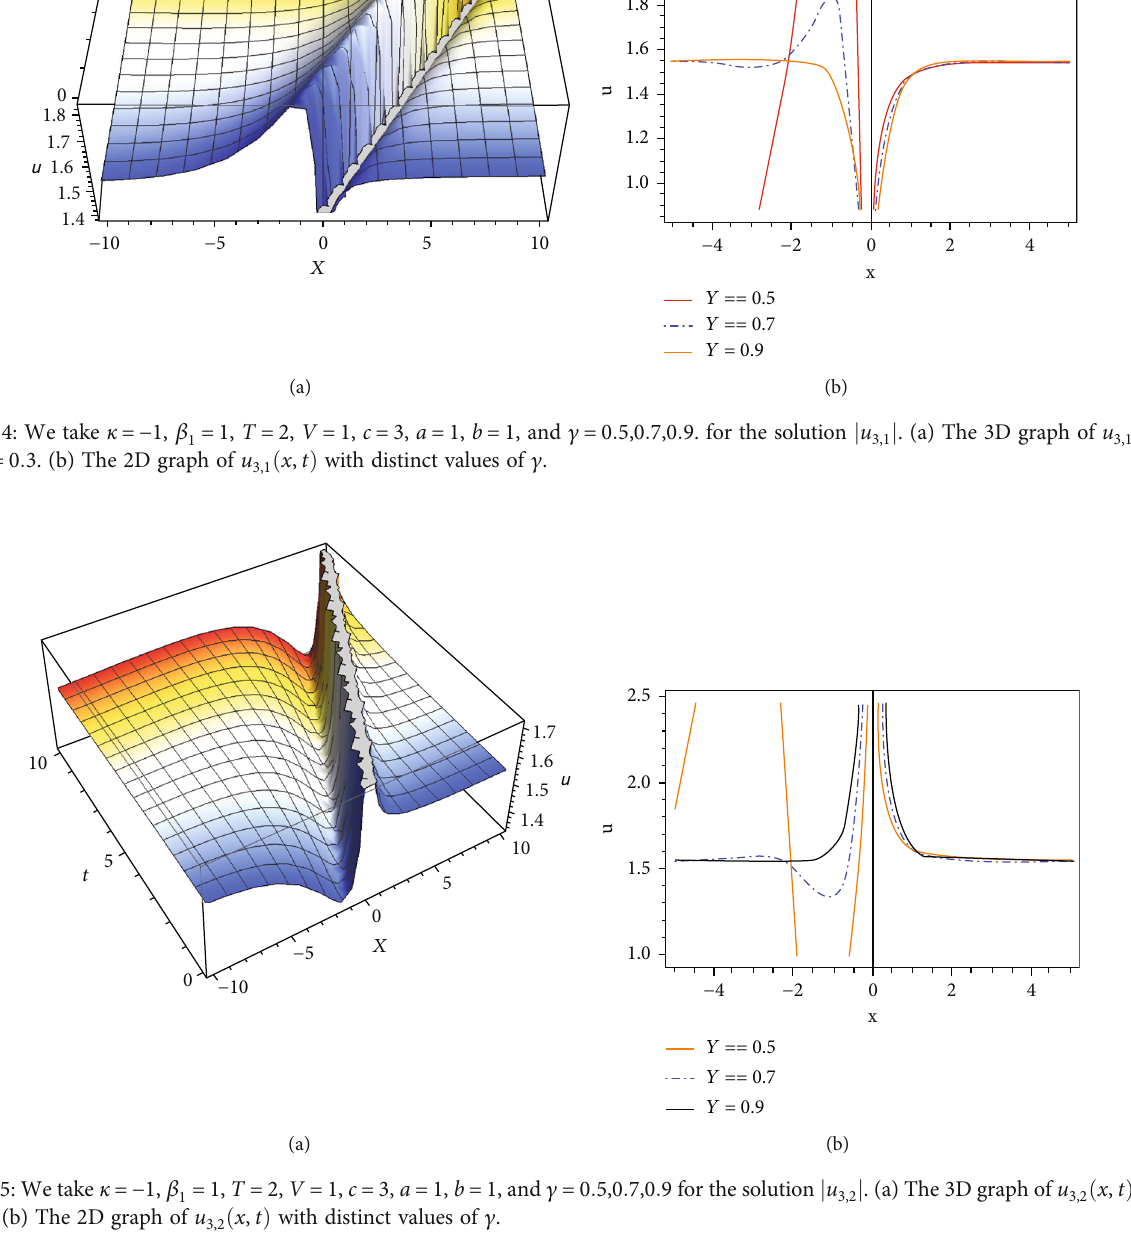
Figure 5: We take κ = − 1 , β γ = 0 : 3 . (b) The 2D graph of u